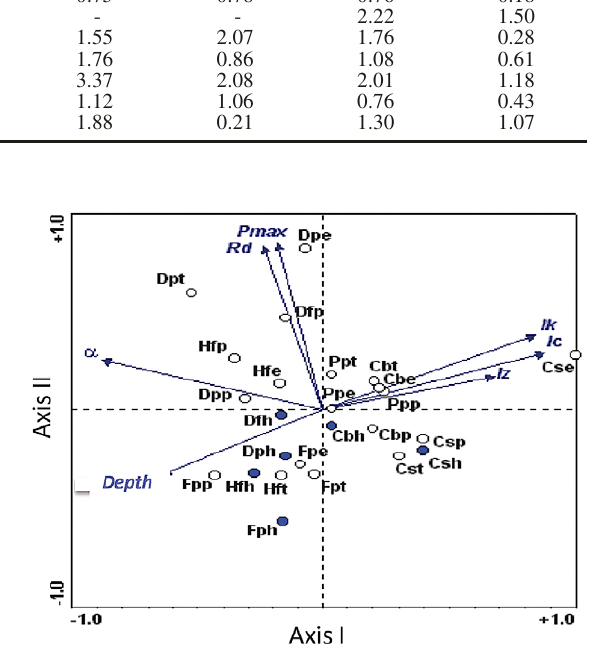
Fig. 5. – Representation of the species and seasons in a plane de- fined by axes I and II from a PCA made using the photosynthetic parameters as variables. Depth and I (irradiance at every depth z and season) are not variables but have been incorporated into the representation. Full dots indicate winter samples. Every species and season is indicated by the same abbreviation as that used in Figure 4 followed by season (p, spring; e, summer; t, autumn; h,